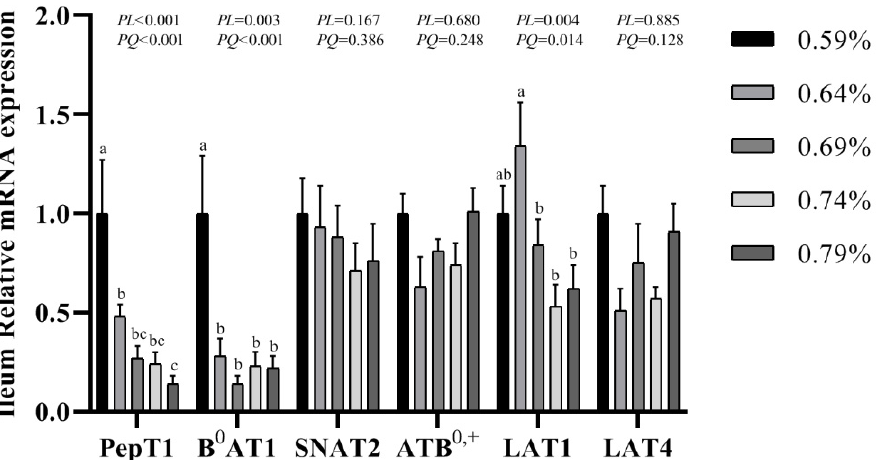
Figure 5. Effects of dietary valine levels on mRNA expression levels of PepT1, B 0 AT1, SNAT2, ATB 0,+ , LAT1, and LAT4 in ileum of laying hens. Values are represented as the mean and SEM (n = 6–8). Means with different superscript letters (a–c) within a column differ significantly ( p < 0.05).